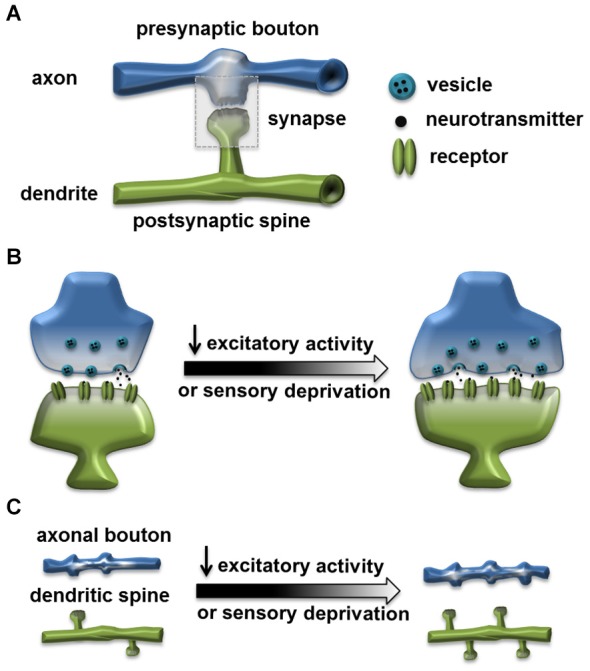
Homeostatic structural change at the excitatory synapse. (A) A typical excitatory synapse. Synapse is formed through connection of the presynaptic axonal bouton, containing the presynaptic active zone (AZ) with the readily releasable neurotransmitter vesicles, and the postsynaptic dendritic spine, containing the postsynaptic density (PSD) that organizes neurotransmitter receptor clusters. (B) Reduced excitatory activity or sensory deprivation can lead to structural changes including: enlarged spine, increased size of active zone and increased number of vesicles (Murthy et al., 2001; Wallace and Bear, 2004; Keck et al., 2013). (C) Reduced excitatory activity or sensory deprivation can also lead to an increased axonal bouton number (Yamahachi et al., 2009; Kremer et al., 2010); increased dendritic spine number (Kirov and Harris, 1999); or reduced spine elimination rate (Zuo et al., 2005).